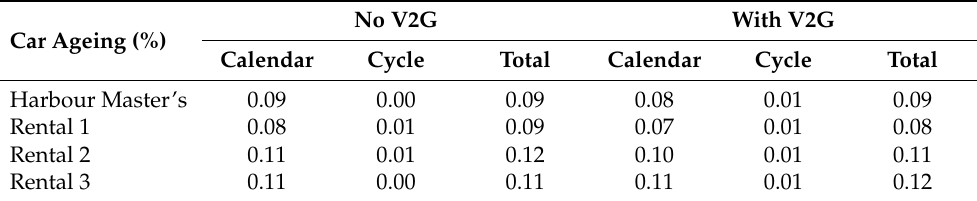
Table 4. Weekly battery degradation of electric